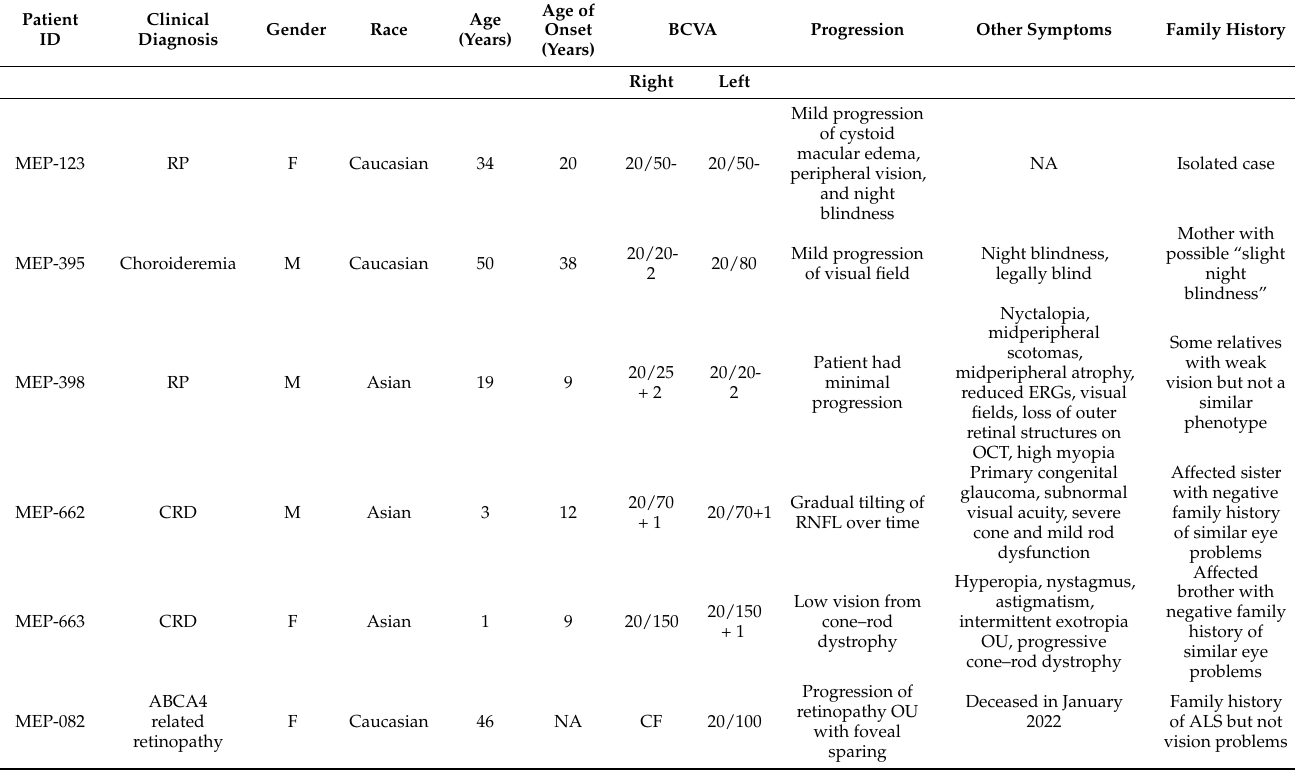
Table 2. Clinical features of selected IRD